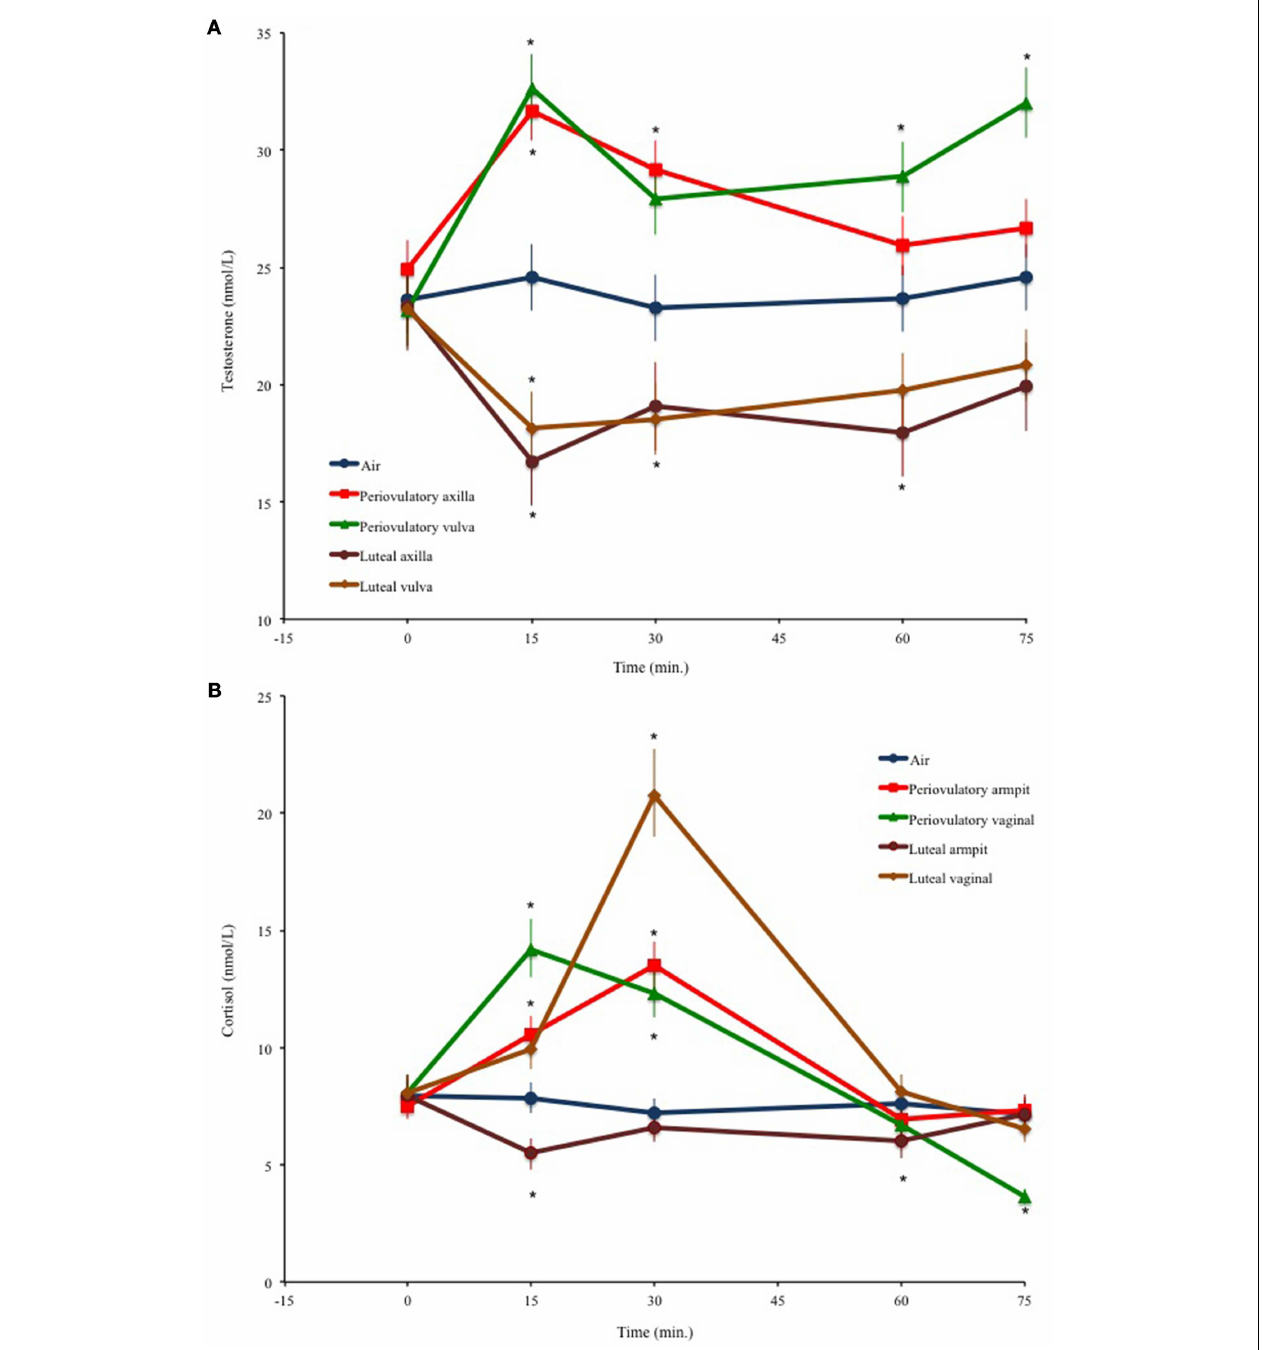
FIGURE 1 | Men’s mean ( ± SEM) temporal variations of (A) salivary testosterone and (B) salivary cortisol levels after smelling air or different female odors . * p < 0.05 compared to basal values.